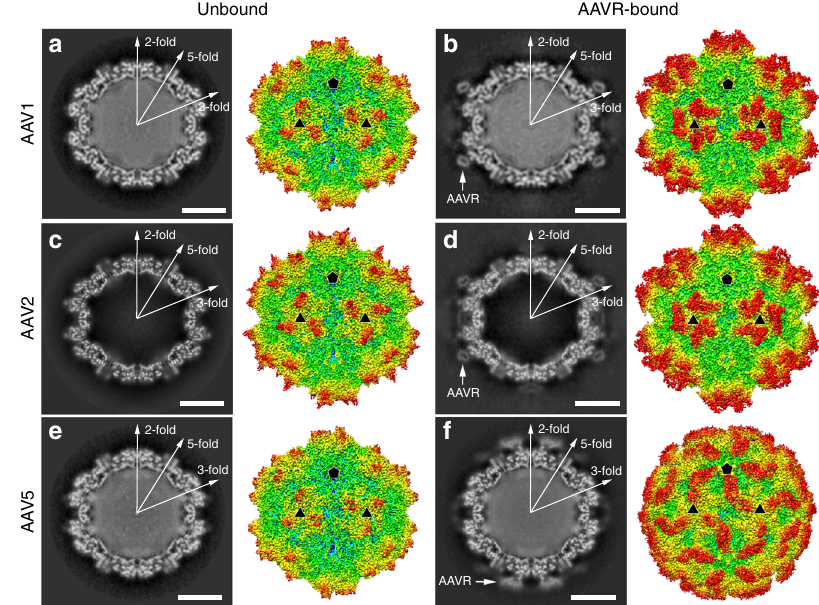
Fig. 1 The cryo-EM structures. The central cross-sections through the cryo-EM maps and the rendered images of unbound AAV1 ( a ), AAV2 ( c ), and AAV5 ( e ) and AAVR-bound AAV1 ( b ), AAV2 ( d ), AAV5 ( f ) are shown in the left and right halves of each panel, respectively. The central cross-sections are shown with the icosahedral two-, three- and fi vefold axes. The scale bars represent 100 Å. Depth cueing is used to indicate the radius by color (<90 Å: blue; 100 – 125 Å: from cyan to yellow; >140 Å: red). Icosahedral fi ve- and threefold axes are represented by pentagons and triangles. Density for bound AAVRs is indicated by arrows in the central